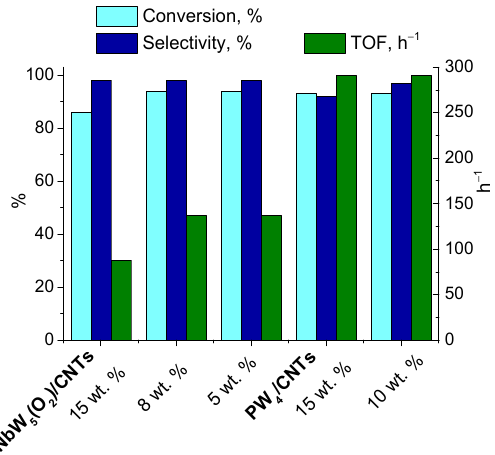
Figure 10. CyO epoxidation over PW 4 /CNTs and NbW 5 /CNTs with various POM content. Reaction conditions: [CyO] = 0.1 М , [H 2 O 2 ] = 0.2 М , catalyst 10–30 mg (0.7 μ mol PW 4 or 0.8 μ mol NbW 5 ), conditions: [CyO] = 0.1 M, [H 2 O 2 ] = 0.2 M, catalyst 10–30 mg (0.7